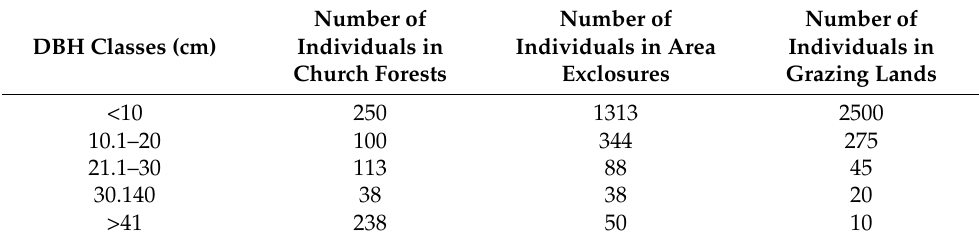
Table 5. Population status in different DBH-classes in the lowland study areas. DBH Classes (cm)